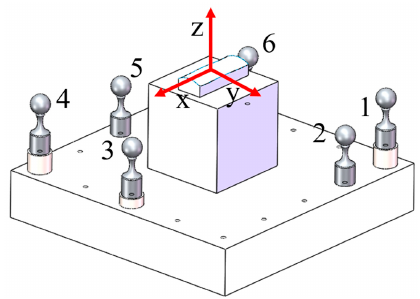
Figure 4. Designed fiducials fixture with a workpiece.